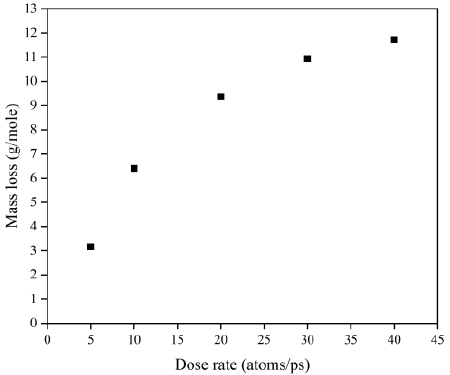
Figure 24. Mass changes of the Kapton during atomic oxygen impact at different dose rates.